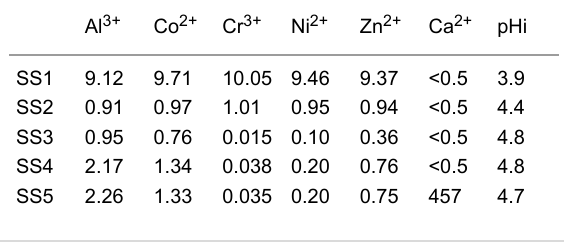
Table 6: Concentrations of metals and calcium expressed in mg·L − 1 in the spiked